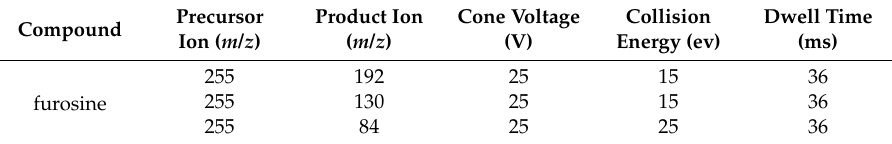
Table 4. UPLC-MS settings for multiple reaction monitoring